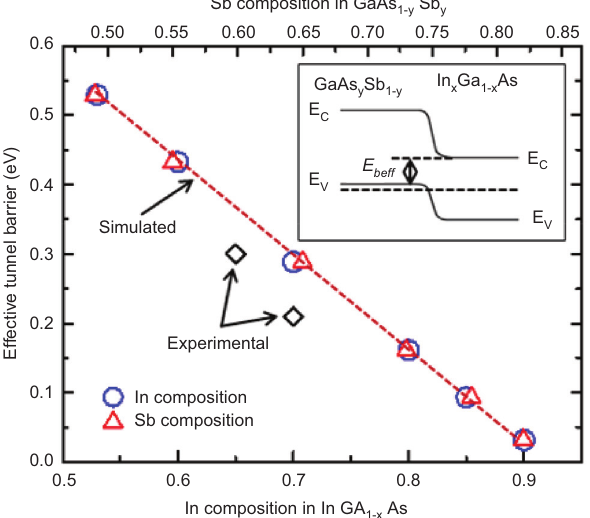
Figure 15 A comprehensive consideration of a TFET design.